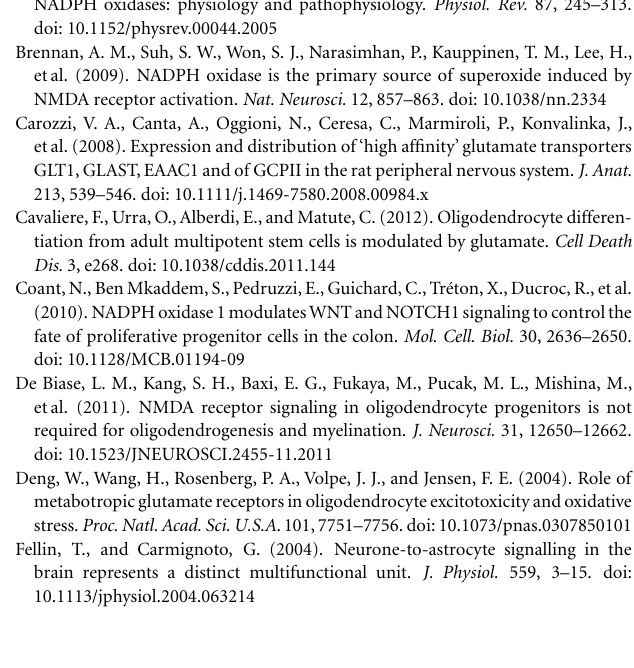
FIGURE 5 | Schematic representation of the hypothetical NMDA receptor-induced oligodendrocyte differentiation. High levels of extracellular glutamate trigger NMDA receptor responses which activate